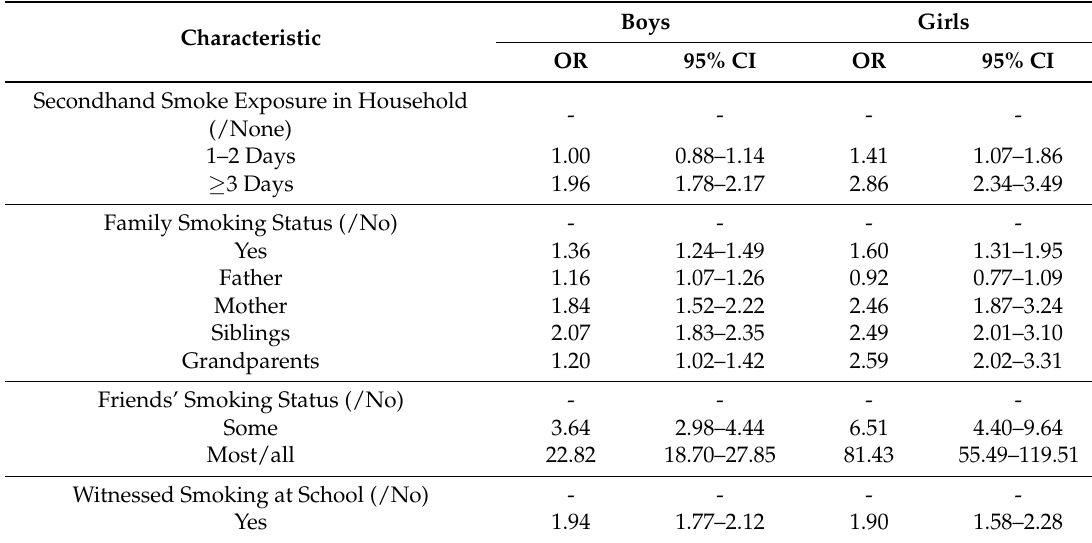
Table 4. Odds ratios (95% CI) for current electronic cigarette smoking a